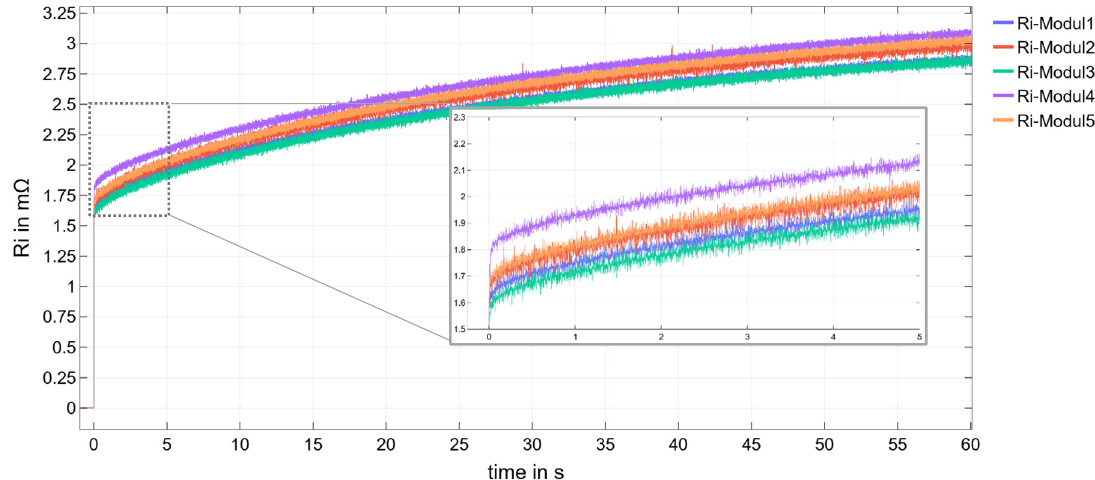
Figure 8. Internal resistance curves of the modules calculated from the voltage change in the relaxation phase at 30% SOC. In order to better recognize the differences in the first seconds, this is shown enlarged. The raw data display contains measurement noise, which underlines the importance of precise voltage measurement.